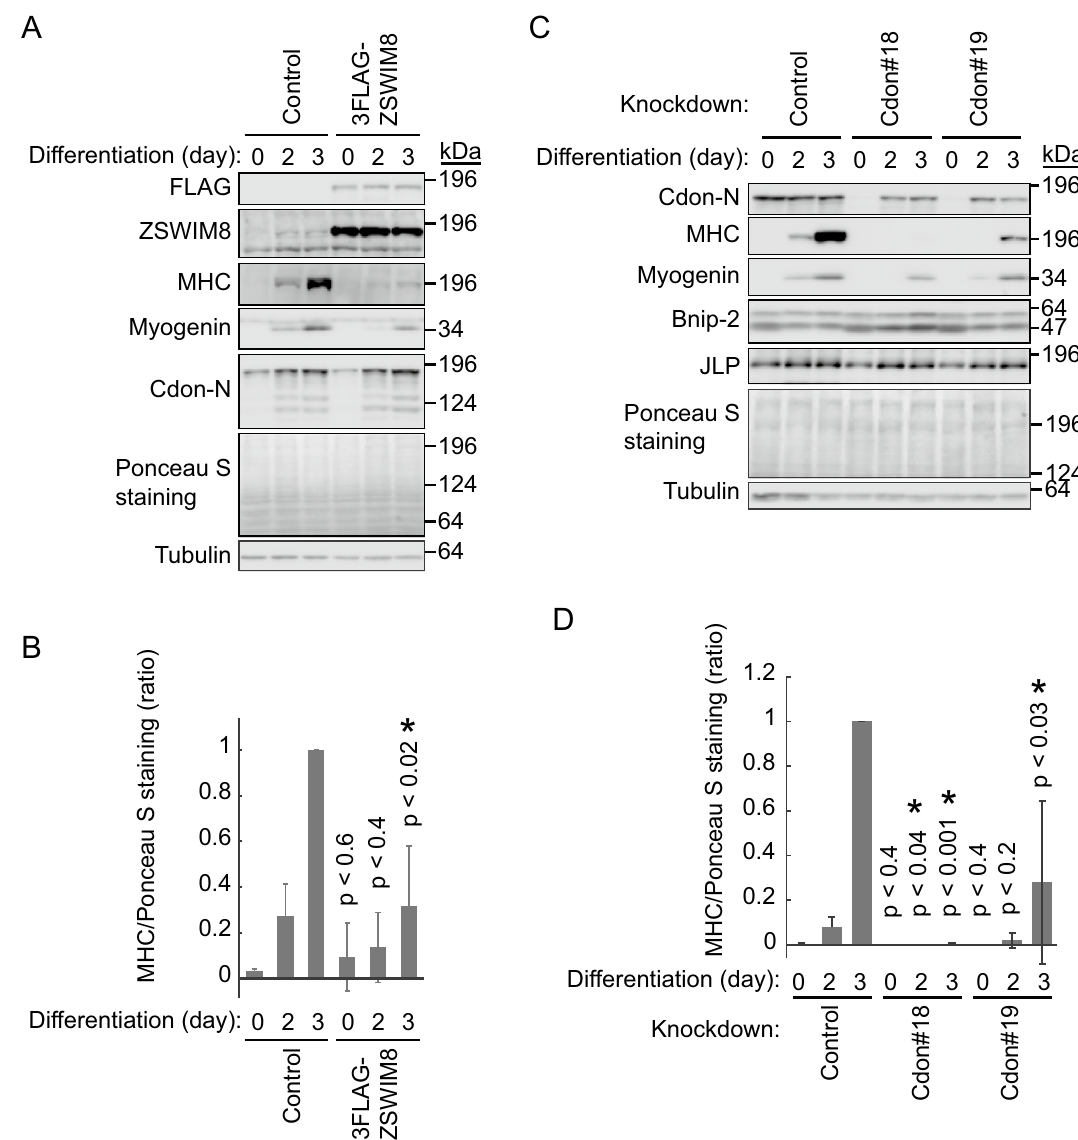
Figure 5. Prevention of C2C12 differentiation by ZSWIM8 overexpression or knockdown of Cdon. ( A ) Prevention of C2C12 differentiation by overexpression of ZSWIM8. Control or 3 × FLAG-ZSWIM8-expressing C2C12 cells were differentiated for 2 or 3 days. The cell lysates were subjected to immunoblotting with an anti- FLAG, ZSWIM8, myosin heavy chain (MHC), myogenin, or Cdon-N antibody. Tubulin and Ponceau S staining were used as loading controls. Representative data of three independent experiments. ( B ) Quantification of MHC expression in ( A ). MHC signals were normalized to that of Ponceau S staining. Expression in control cells after 3 days of differentiation was set as 1. Data represent the mean ± SD of three independent experiments. ( C ) Prevention of C2C12 differentiation by Cdon knockdown. Control or Cdon-knockdown (#18 or 19) C2C12 cells were differentiated for 2 or 3 days. The cell lysates were subjected to immunoblotting with an anti-Cdon-N, MHC, myogenin, Bnip-2, or JLP antibody. Bnip-2 showed doublet bands. Tubulin and Ponceau S staining were used as loading controls. Representative data of three independent experiments. (D) Quantification of MHC expression in ( C ). MHC signals were normalized to that of Ponceau S staining. Expression in control cells after 3 days of differentiation was set as 1. Data represent the mean ± SD of three independent experiments. Asterisk indicates statistical significance compared to the control sample. The membranes in ( A ) and ( C ) were cut prior to hybridization with antibodies. Full-length blots are presented in Supplementary Fig.